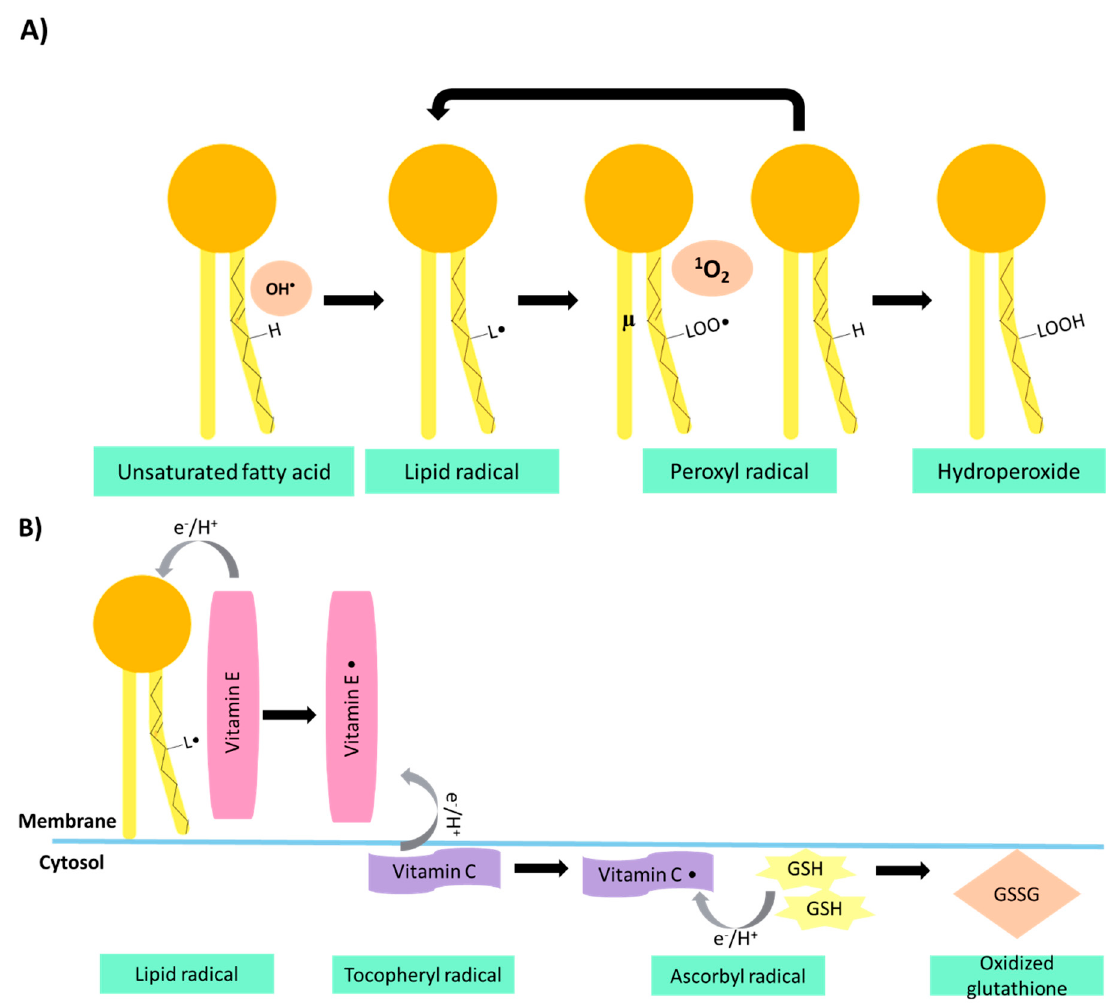
Figure 2. Lipid peroxidation, action, and regeneration of vitamin E. ( A ) Peroxidation begins with the free radical attack against unsaturated fatty acids of the cell membrane, becoming lipid radicals, and in the presence of oxygen, peroxyl radicals are formed. These radicals will attack the nearest fatty acids to form hydroperoxide, generating new lipid radicals, and thus continue the reaction. ( B ) Vitamin E is embedded within the cell membrane, where it donates an electron (e − ) and a proton (H +) to the L • and LOO • radicals to neutralize them, becoming α -tocopheryl radicals. This radical is neutralized by the vitamin C, donating an e − and H +, neutralizing the α -tocopheryl radical, generating ascorbyl radicals. Subsequently, two glutathione (G.S.H.) donate an e − and an H + to regenerate vitamin C, becoming oxidized glutathione (G.S.S.G.).